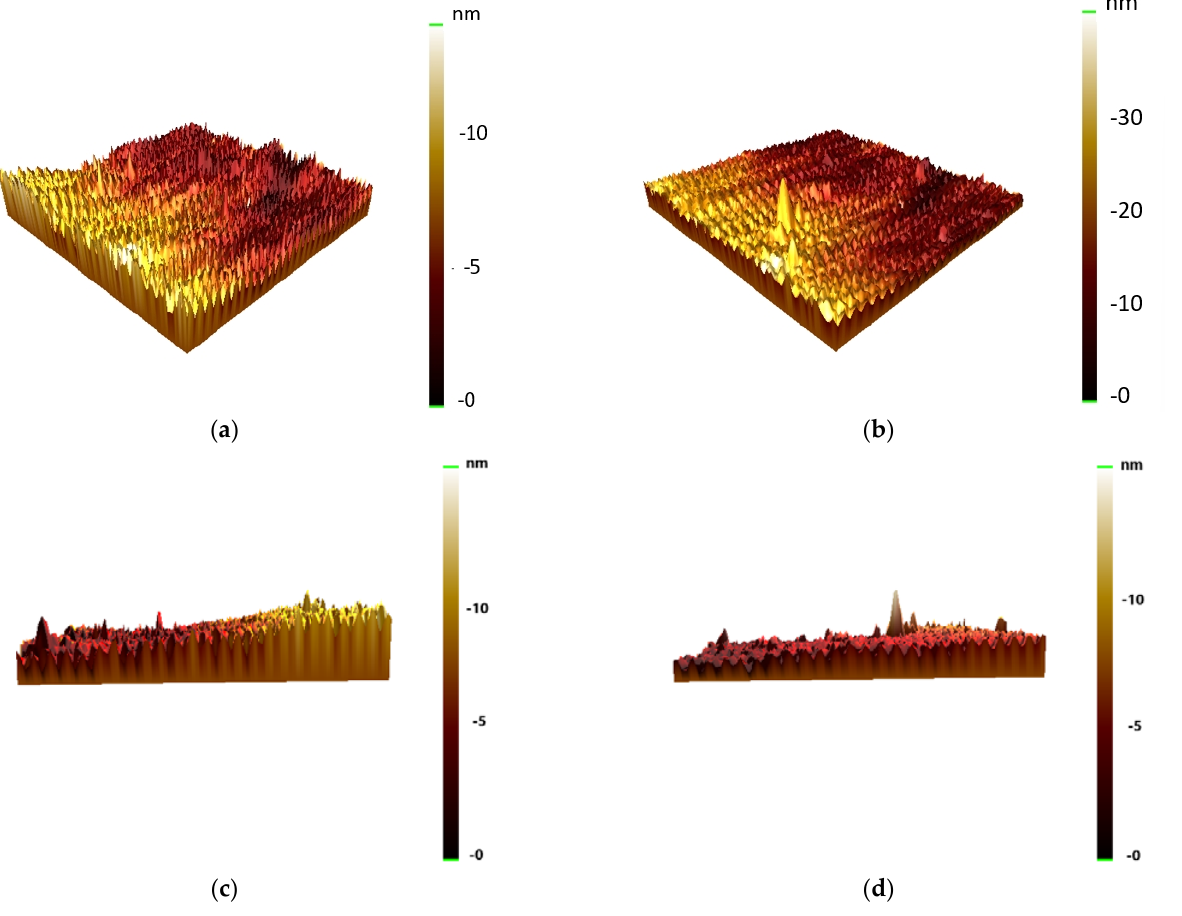
Figure 3. AFM surface morphology at RT at ( a ) 10 nm and ( b ) 40 nm. AFM profiles across the film edge at ( c ) 10 nm and ( d ) 40 nm.